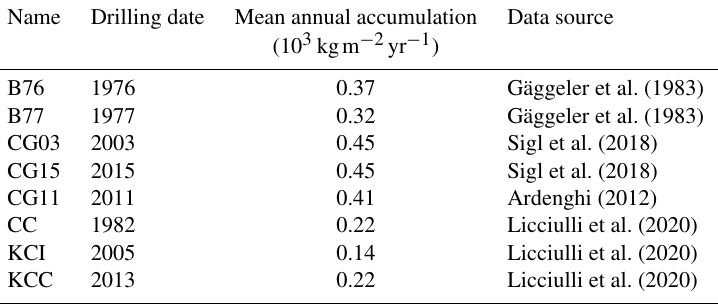
Table 2. Ice core data employed in the case